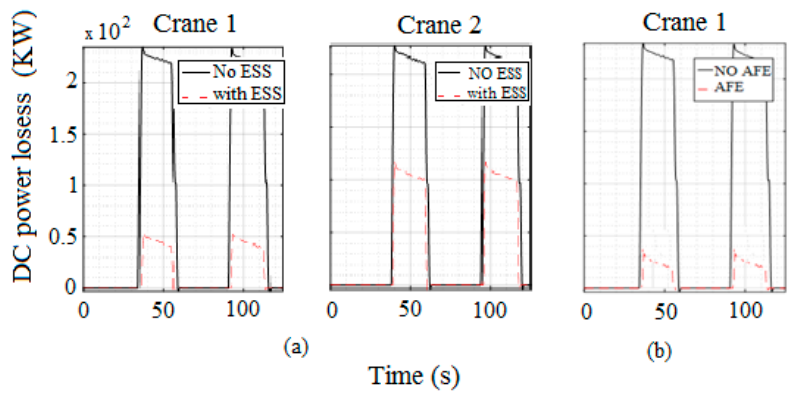
Figure 8. An example for the power losses of (a) the crane 1 and crane 2 (ESS model) and (b) AFE.